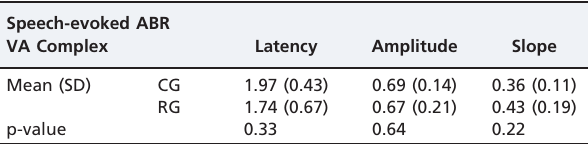
Table 3 - Control and Research Groups’ means and SD of VA latency (ms), amplitude ( m V) and slope ( m V/ms) speech- evoked measures.